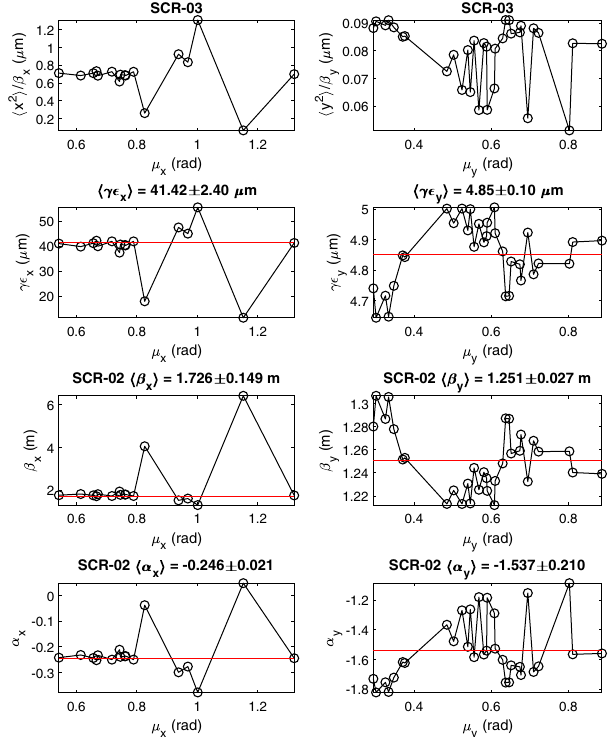
FIG. 3. Emittance and optical functions measured using the three-screen analysis technique for (left) horizontal and (right) vertical planes. The horizontal axis on each plot shows the phase advance between SCR-02 and SCR-03; each point represents the results for a single set of quadrupole strengths between these two screens. The plots show (from top to bottom): the mean-square beam size observed at SCR-03 scaled by the beta function; the normalized emittance; the Courant – Snyder beta function at SCR-02; the Courant – Snyder alpha function at SCR-02. The emittance, beta function, and alpha function are calculated from the covariance matrix at SCR-02 using (27) and (28). The beta function at SCR-03 (used for scaling the beam size) is calculated by propagating the Courant – Snyder functions from SCR-02 using the appropriate transfer matrix. Points leading to imaginary values for the emittance are omitted. Error ranges show the standard deviation across the measurements, omitting points with large deviation from the